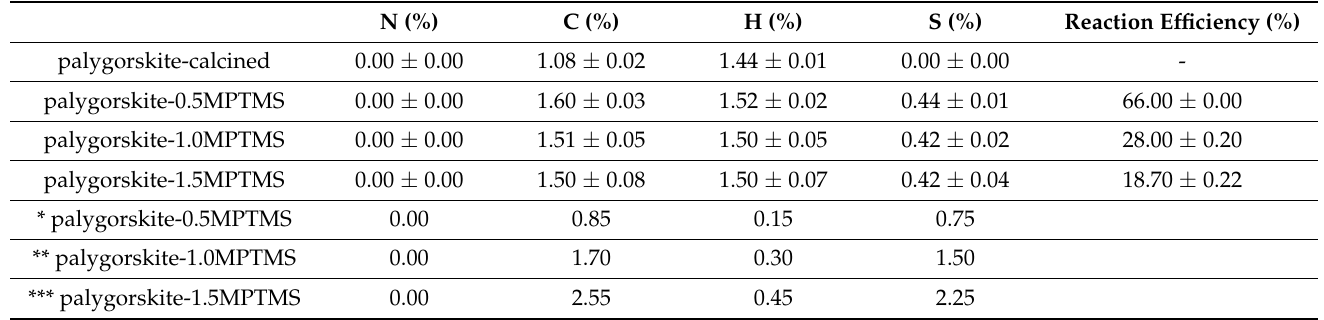
Table 1. The content of nitrogen, carbon, hydrogen, and sulfur in the calcined and functionalization of palygorskite, and the reaction efficiency of